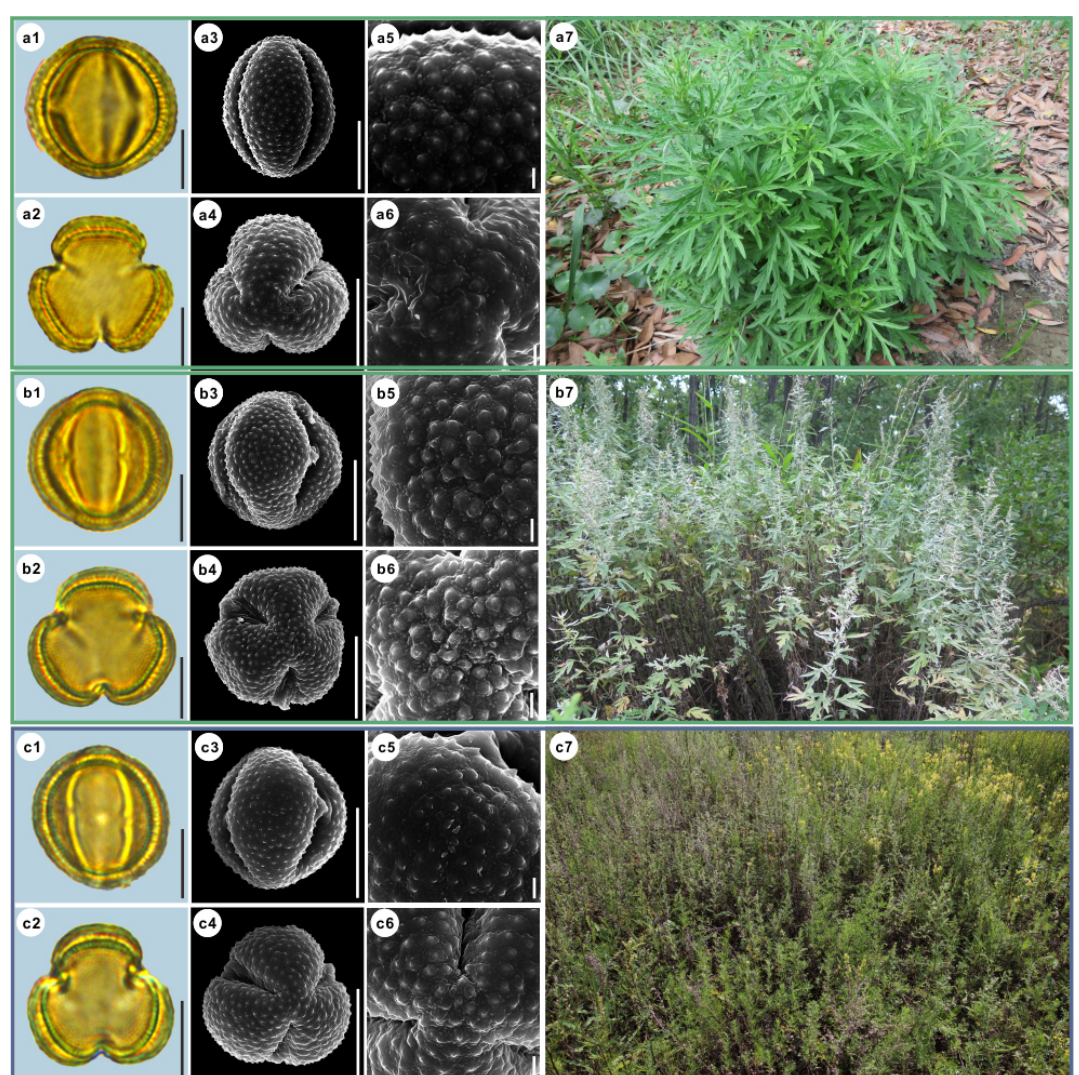
Figure 4. Pollen grains and the habitats of their source plants. (a) Artemisia indica ; (b) Artemisia argyi ; and (c) Artemisia mongolica . Pollen grains in equatorial view under LM (a1, b1, c1) and SEM (a3, a5, b3, b5, c3, c5) , in polar view under LM (a2, b2, c2) and SEM (a4, a6, b4, b6, c4, c6) , along with the habitats of their source plants (a7 cited from https://www.inaturalist.org/photos/66336449, last access: 19 August 2022, by © yangting, b7 cited from https://www.inaturalist.org/photos/95820686, last access: 19 August 2022, by © Sergey Prokopenko, c7 cited from https://www.inaturalist.org/photos/163584035, last access: 19 August 2022, by © Nikolay V Dorofeev). Scale bar in LM and SEM overview 10µm, and in SEM close-up